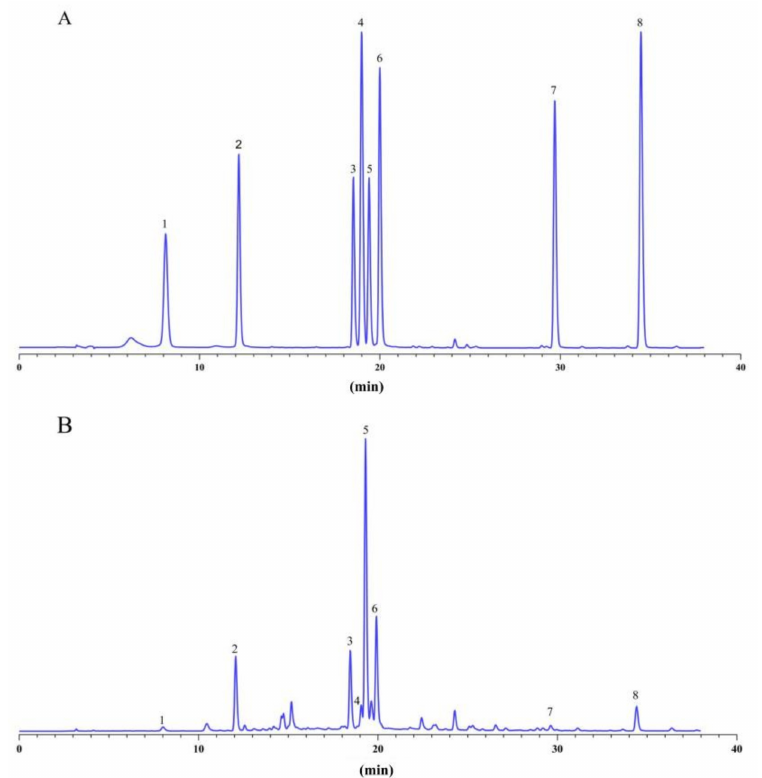
Figure 1. HPLC chromatogram of mixed standard solution ( A ) and sample solution ( B ); 1: neochloro- genic acid; 2: chlorogenic acid; 3: isochlorogenic acid B; 4: 7-hydroxycoumarin; 5: isochlorogenic acid A; 6: isochlorogenic acid C; 7: jaceosidin; 8: